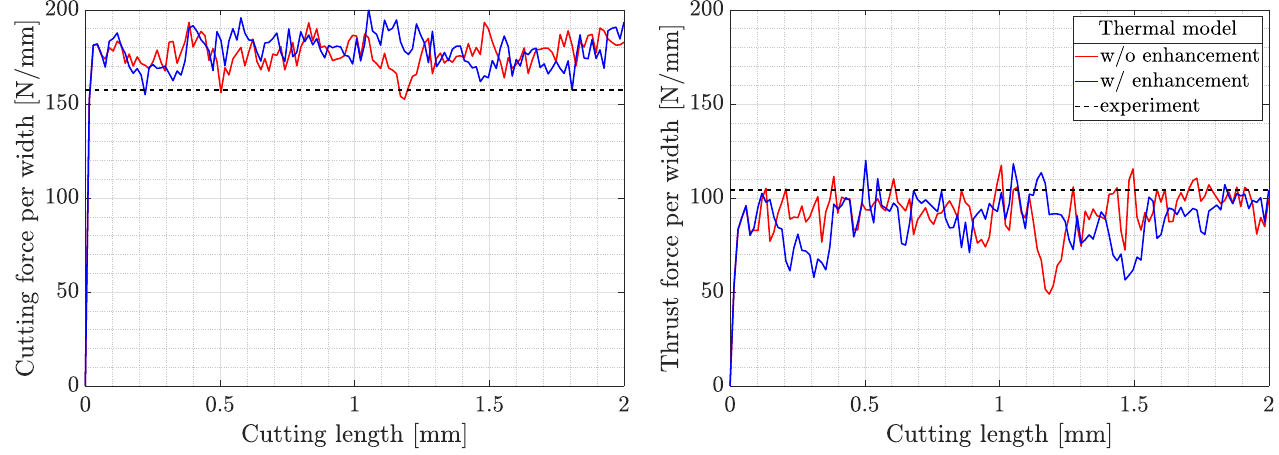
Figure 5. Evolution of predicted forces compared to the experimental